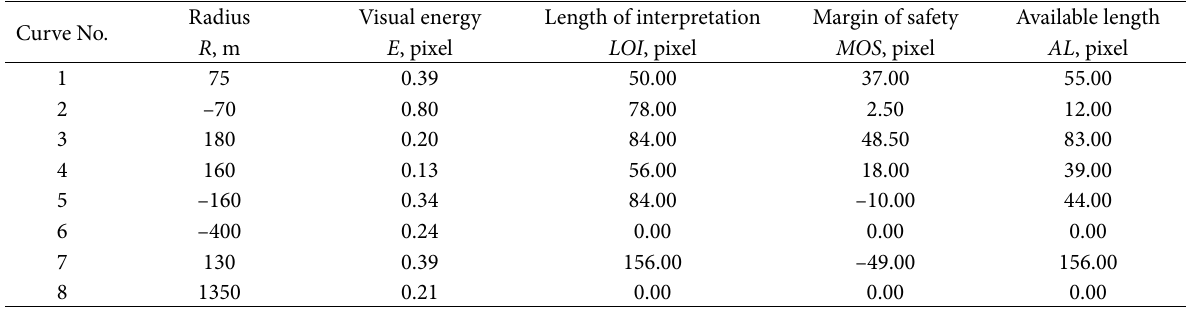
Table 1. Relationship among geometrical and visual variables Curve No.